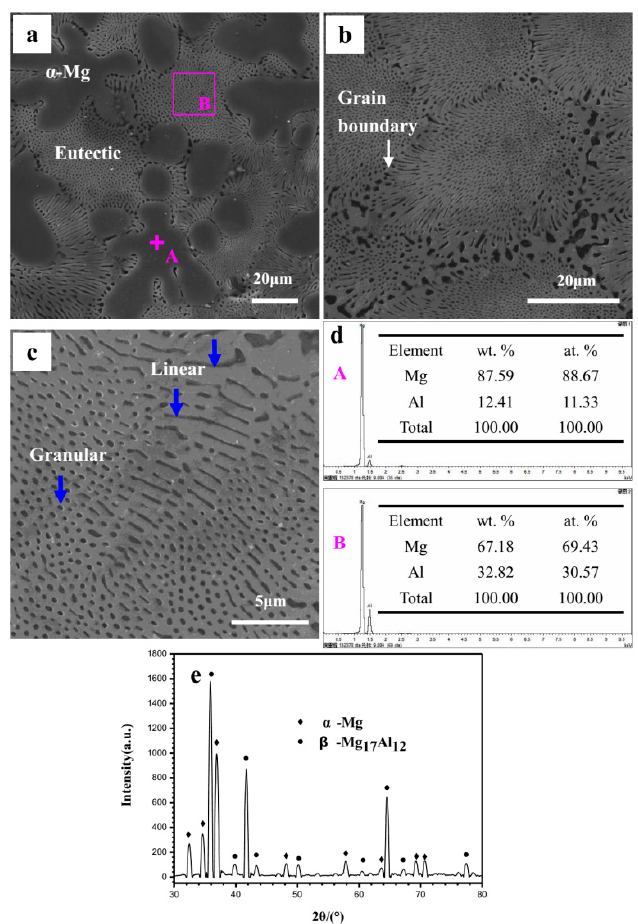
Figure 1. The cast Mg–Al alloy’s microstructure: ( a ) Cast Mg–Al alloy; ( b ) SEM image of eutectic structure at high resolution; ( c ) linear and granular like α -Mg phases in eutectic; ( d ) EDS analysis results at sites A and B in the SEM image ( a ); ( e ) the Mg–Al alloy’s XRD test result.